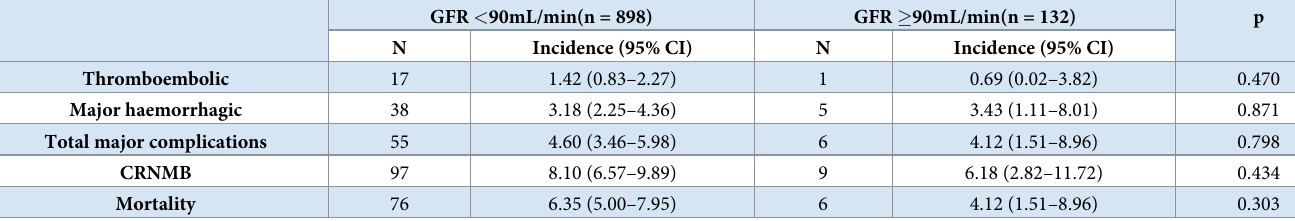
Table 3. Complications by GFR: Number/incidence (%